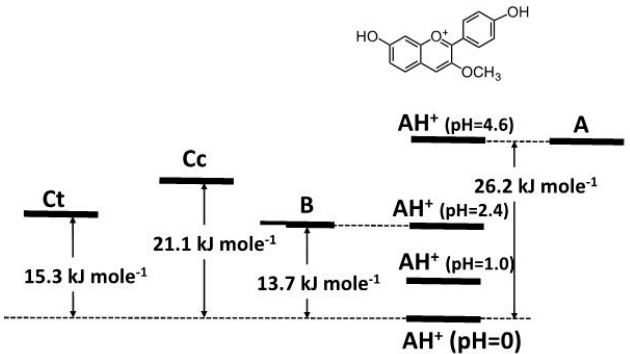
Table 5. Rate constants of the compound 4’,7-dihydroxy-3-methoxyflavylium.